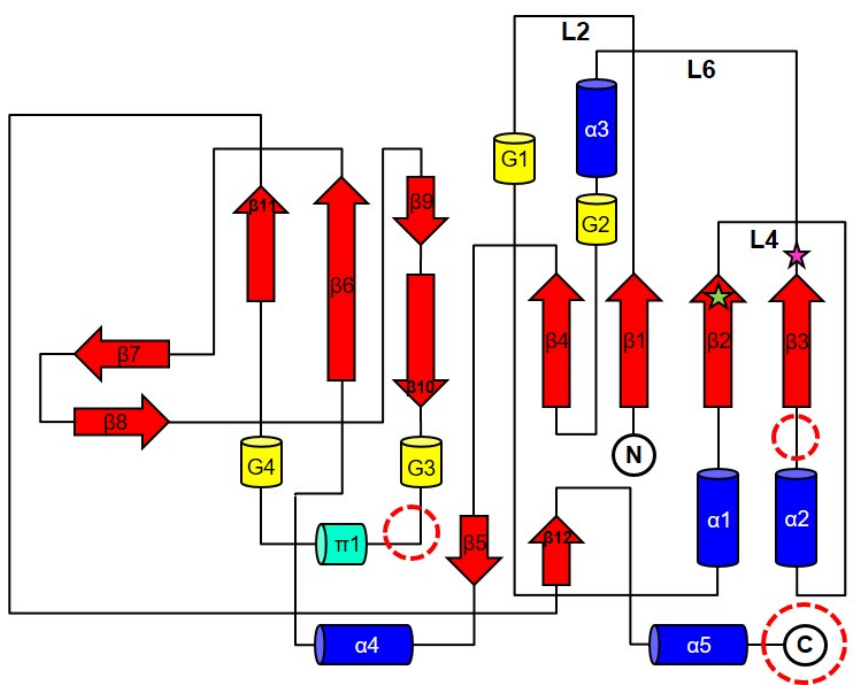
Figure 2. The general topology diagram of sugar nucleotidylyltransferases based on Yp HddC. The secondary structures were drawn and labeled with α for α -helix ( blue cylinder ), β for β -strand ( red arrows ), π for π -helix ( green cylinder ), and G for 3 10 -helix ( yellow cylinder ). The dotted circles represent where additional domains are frequently observed in the sugar nucleotidylyltransferase family. L represents a loop. The green star represents the residue, Ser53, and the pink star represents Glu80. They were the residues for the point mutation.